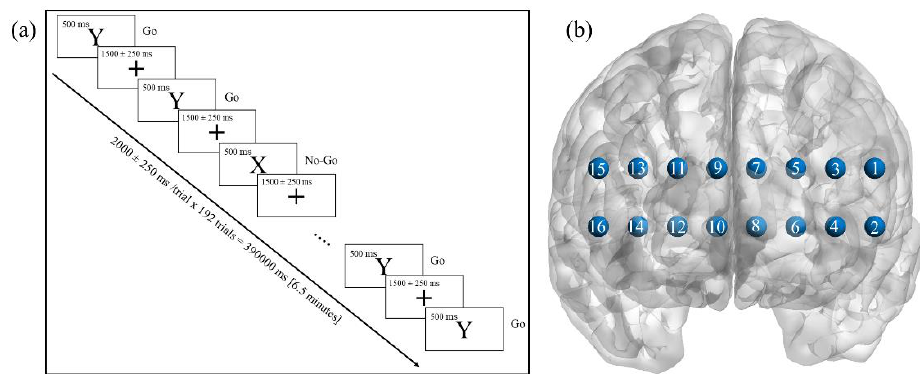
Figure 1. Experimental protocol; ( a ) experimental paradigm during a simple GNG task, letter Y: Go stimulus, letter X: No-Go stimulus, + sign: inter-stimulus rest. Letter Y was replaced by a photo of a neutral face and letter X was replaced by a photo of a happy or angry face during the emotional GNG task; ( b ) location of 16 fNIRS channels in a brain model.